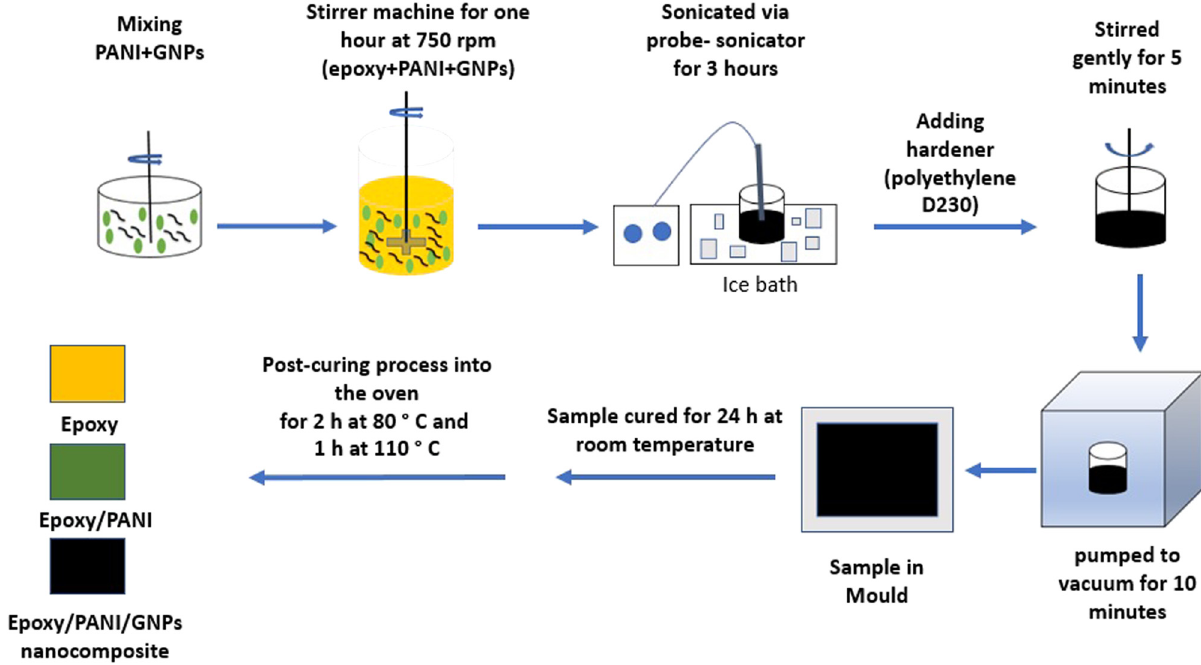
Figure 1: Schematic diagram of the epoxy/PANI/GNPs melt - blending